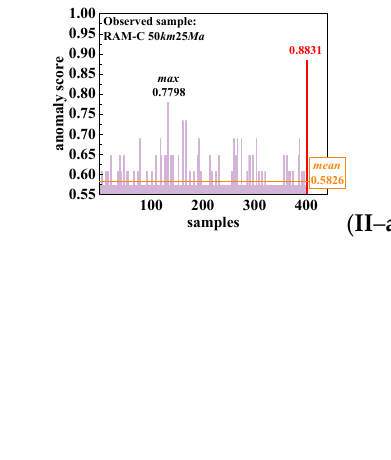
Figure 12. Anomaly scores of subclasses and data streaming. ( 1 ) Condition 1. ( 2 ) Condition 2. ( 3 ) Condition 3. ( a ) 40 km 15 Mach. ( b ) 40 km 20 Mach. ( c ) 40 km 25 Mach. ( d ) 50 km 15 Mach. ( e ) 50 km 20 Mach. ( f ) 50 km 25 Mach.